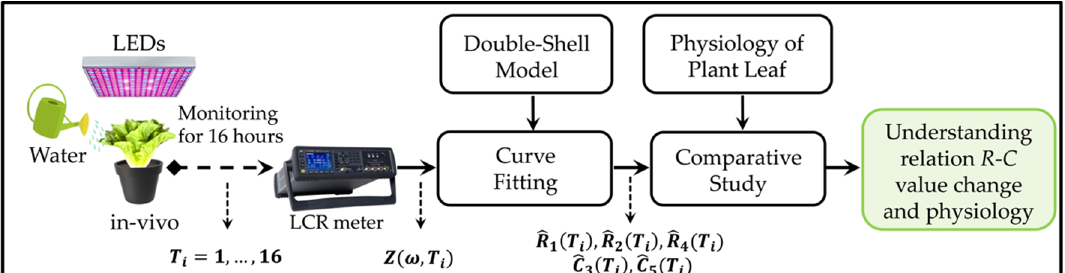
Figure 5. Outline of this work. T i and ω are the measured time index and the angular frequency of measurement, respectively. The impedance Z ( ω , T i ) from the LCR meter is time- and frequency- dependent. After curve fitting, the estimated R and C values ( ˆ R 1 ( T i ) , ˆ R 2 ( T i ) , ˆ R 4 ( T i ) , ˆ C 3 ( T i ) , ˆ C 5 ( T i ) ) were obtained as a function of time with the double-shell model. They were used to understand physiological changes in lettuce.